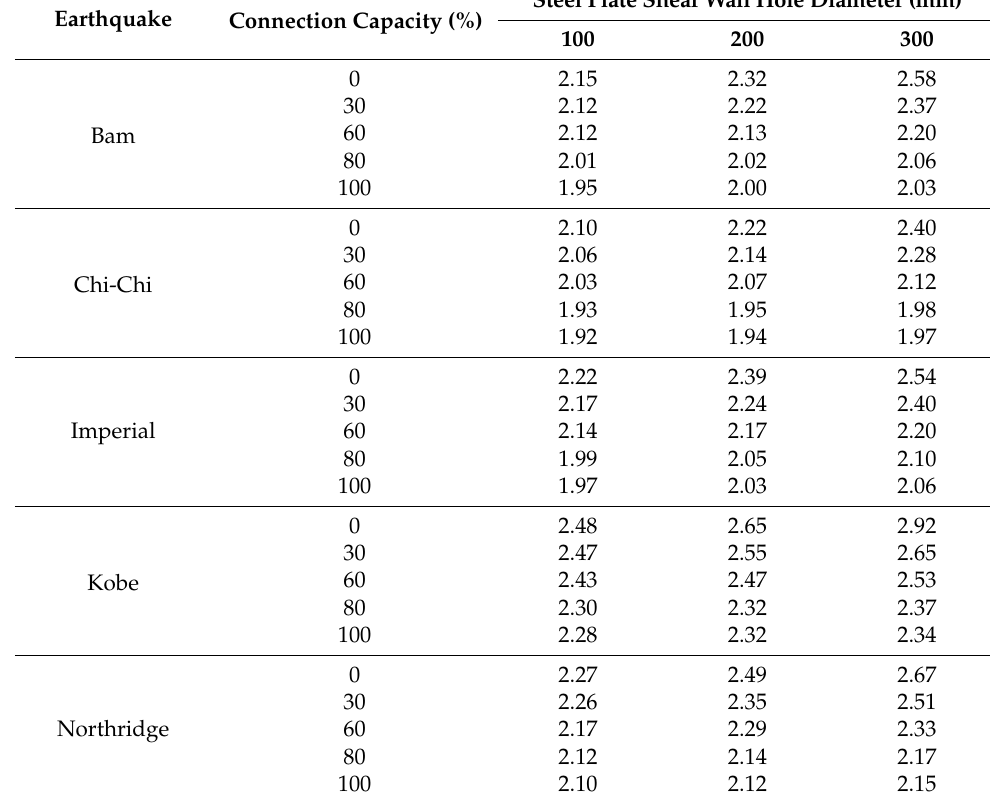
Table 9. Maximum story drift of 15-story frames.